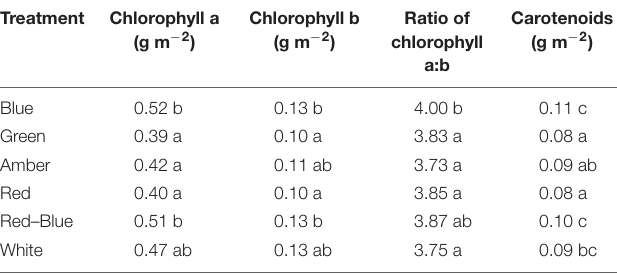
Fraction of light of the treatment color absorbed is calculated by multiplication of absorption characteristics of the leaves by the spectrum of that treatment. Fraction white light absorbed is calculated by multiplication of absorption characteristics of the leaves by the spectrum of white light.